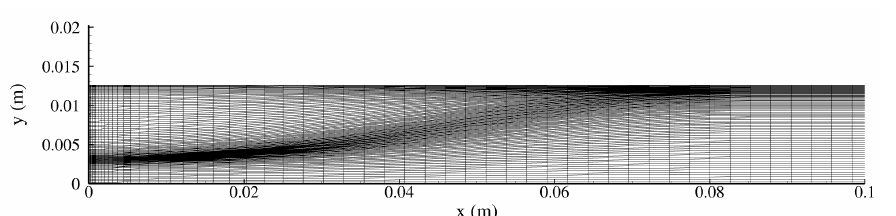
Figure 2. Grid clustering near the injector for the mesh used for numerical simulations of set 1 (see Table 2).